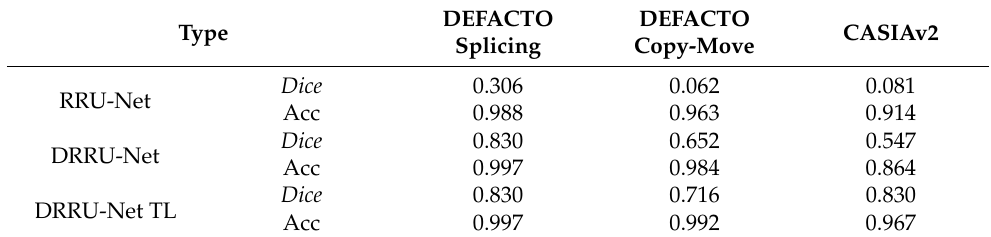
Table 1. Comparison of splicing and copy-move forgery detection performance in pixel units. DEFACTO DEFACTO CASIAv2 Type Splicing Copy-Move Dice 0.306 0.062 0.081 RRU-Net Acc 0.988 0.963 0.914 Dice 0.830 0.652 0.547 DRRU-Net Acc 0.997 Dice DRRU-Net TL